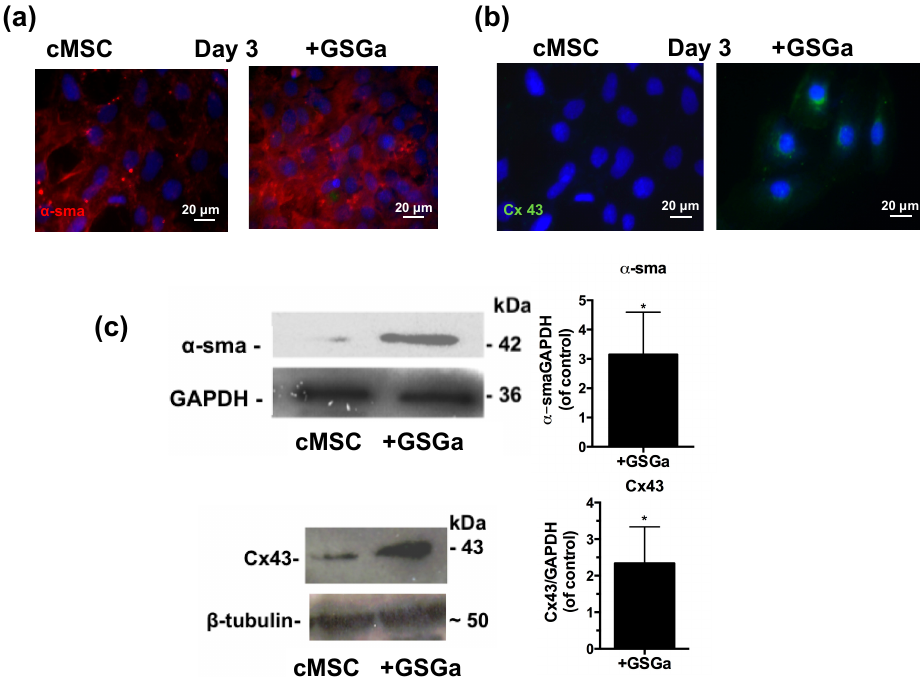
Figure 5. GSGa increases the expression of cardiac phenotype markers. Fluorescent micrographs of 5 × 10 3 cells / cm 2 of cMSC cultured for 3 days in the presence (GSGa) and in the absence of 680 µ g / mL of GSGa, ( a ) α -SMA expression is shown in red and ( b ) Cx43 is stained in green; ( c ) western blotting and densitometric analysis of the protein expression in cMSC after 3 days of treatment with 680 µ g / mL of GSGa. The expression of the proliferation marker and the proteins Cx43 and α -SMA was significantly upregulated after treatment compared to the control. Images are representative of five independent experiments. Error bar indicates S.D. Experiments were performed as three biological replicas. * p value ≤ 0.05 (one-tailed Student’s t-test).